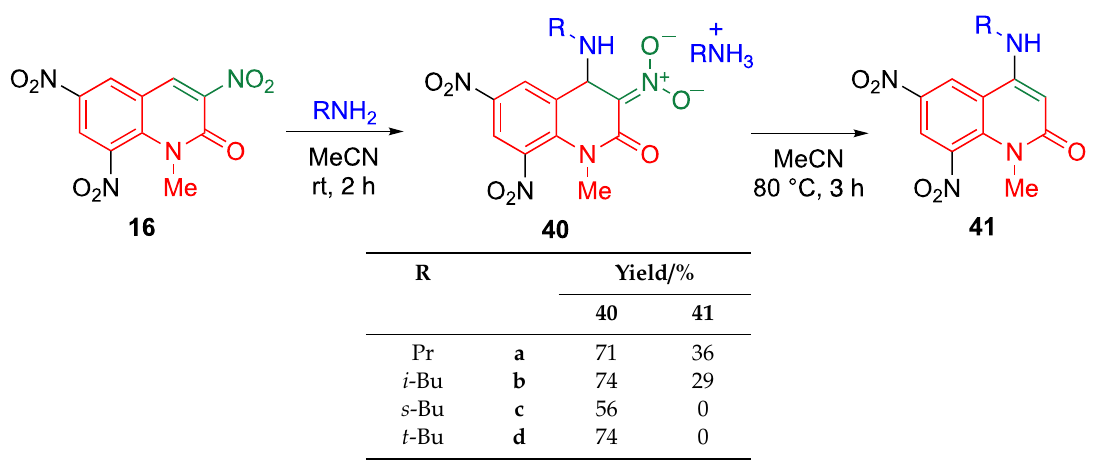
Table 13. cine -Substitution of 16 with primary amines.